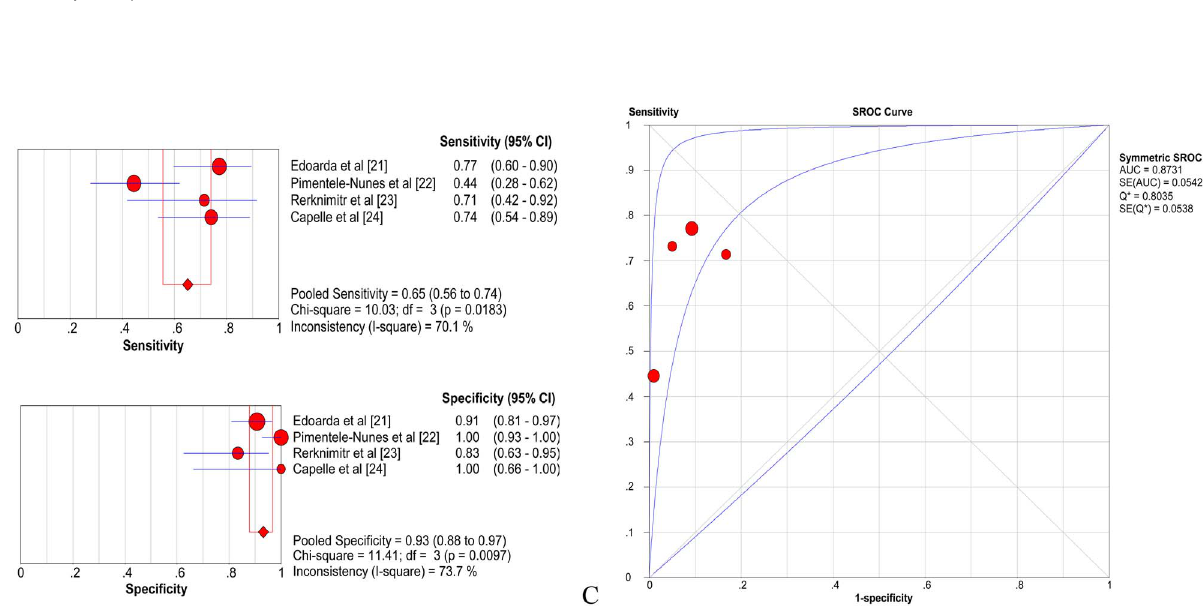
Figure 2. Gastric intestinal metaplasia (GIM), per-patient analysis of diagnostic performance of narrow band imaging (NBI). A. Pooled sensitivity for NBI to differentiate GIM; B. Pooled specificity for NBI to differentiate GIM; C. The summary receiver operating characteristic (SROC) cure for diagnosis by NBI. CI, confidence interval; df, degrees of freedom; AUC, area under curve; SE, standard error.